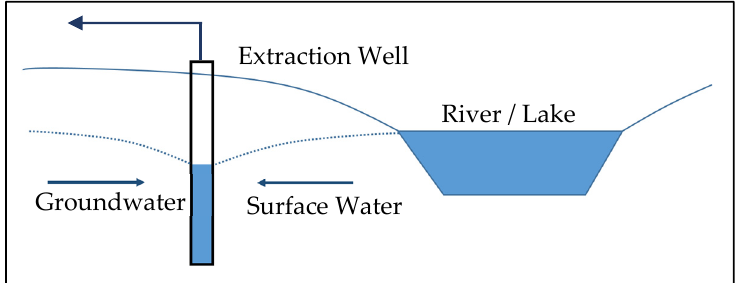
Figure 7. Bank filtration scheme.